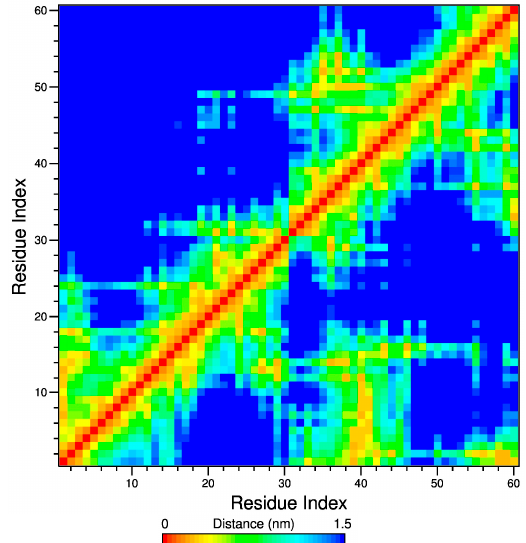
Figure 5. Inter-residues contact map at 283 K in the interval 200–202 ns. The top-left and bottom-right regions across the diagonal refer to atactic and isotactic-rich PNIPAM, respectively.